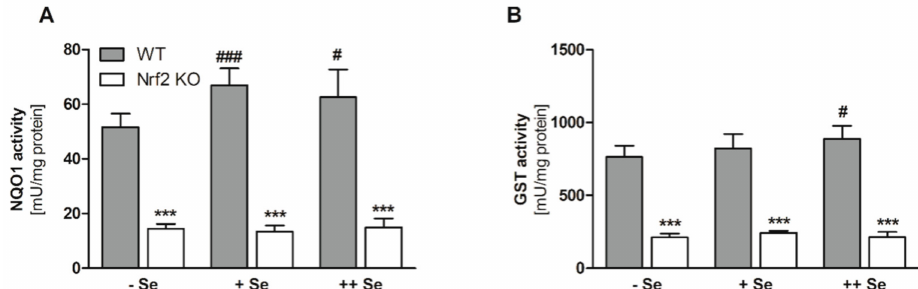
Figure 3. Hepatic enzyme activities as markers for Nrf2 activity. The Nrf2 target gene NQO1 was measured by an activity assay ( A ). Total enzyme activity of all GST isoforms was measured by an activity assay ( B ). Samples were the liver of Nrf2 KO and WT male mice fed diets with defined Se contents (–Se: 0.03 ppm; + Se: 0.15 ppm; ++ Se: 0.6 ppm). Bars represent means + SD ( n = 4–5). *** p < 0.001 vs.